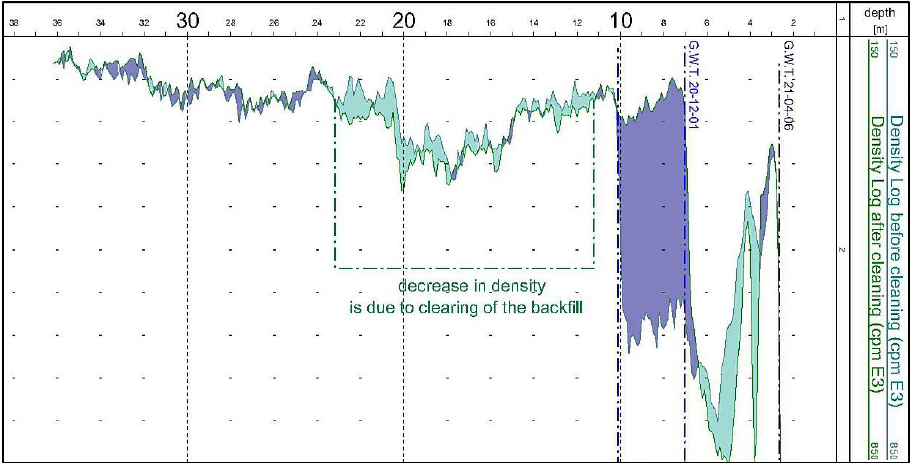
Figure 14. Well gravel pack density log before and after ultrasonic rehabilitation of well MO-4.